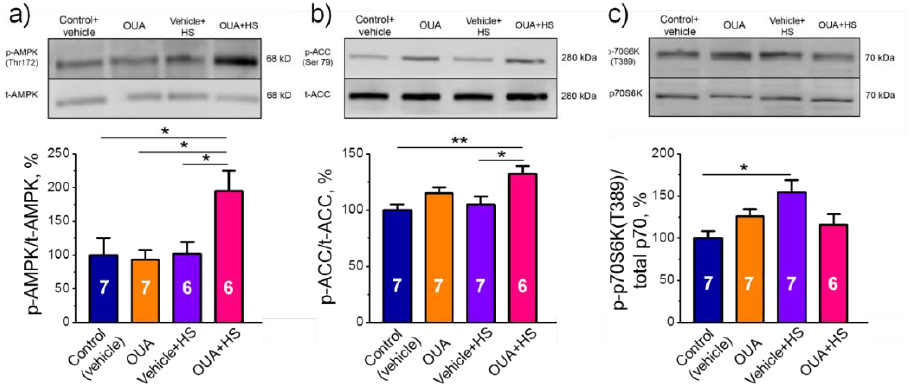
Figure 7. Pre-treatment with ouabain (1 μg/kg) for 4 days elevated the phosphorylation level of AMPK after 6-h HS. The relative phosphorylation levels of AMPK ( a ), ACC ( b ) and p70 ( c ) are shown. ( a – c ) Averaged immunoblots analysis (the number of rats n = 6–7, as indicated); the top panels show corresponding representative immunoblots. Original images for immunoblots are shown in Supplemental Materials. Control and ouabain-treated (OUA) groups are represented by the rats, which received injections of vehicle (0.9% NaCl) or ouabain for 4 days, respectively. HS group contains the rats injected by vehicle followed by HS for 6 h. OUA + HS group is a group of ouabain-injected rats that were exposed for the following 6 h HS. There was a significant interaction between HS and OUA effects for ( a ) p = 0.0373; F (1.22) = 4.915; and ( b ) p = 0.0093; F (1.23) = 8.071. Two-way ANOVA followed by Tukey’s multiple comparisons test. * p < 0.05, ** p < 0.01—compared as indicated by horizontal bars.